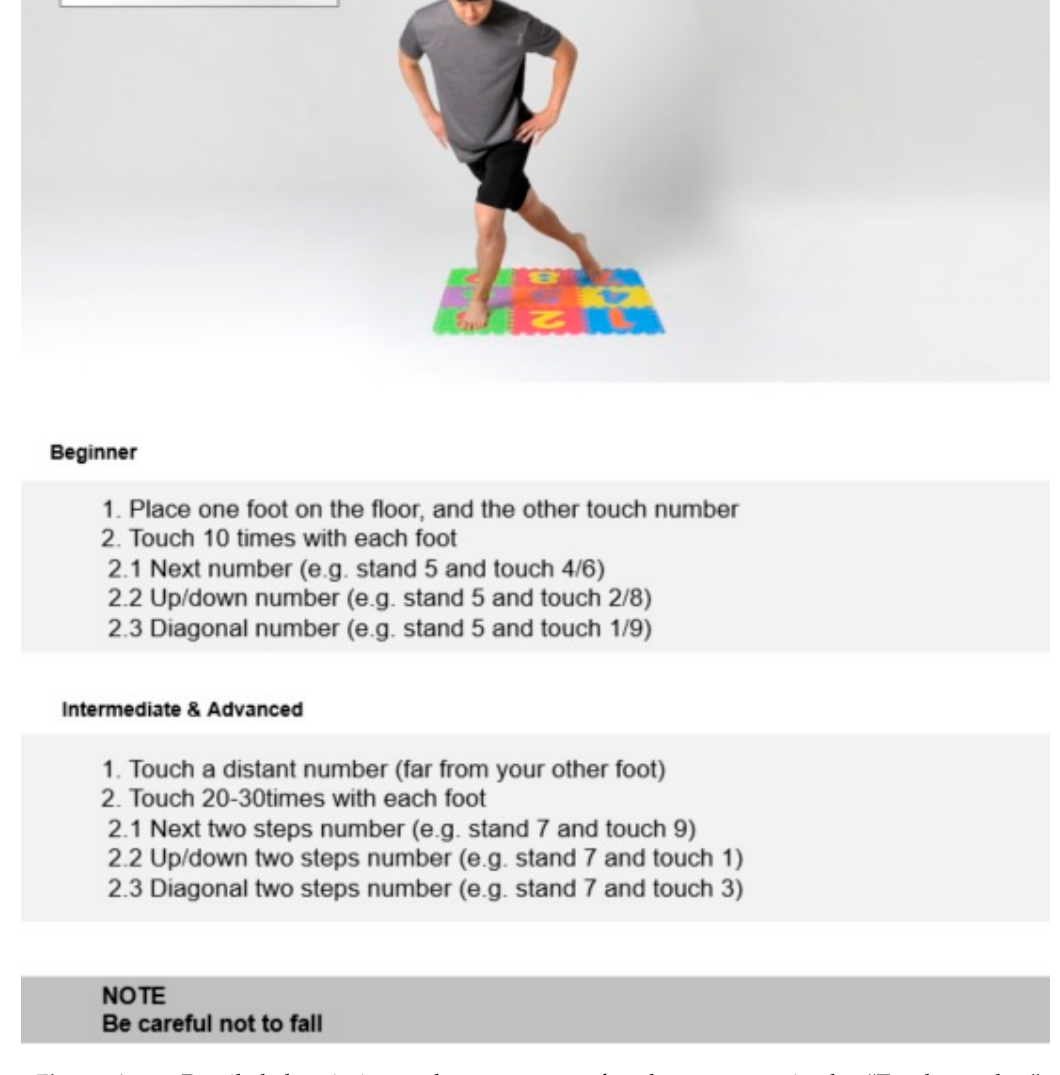
Figure A19. Detailed description and components of each movement in the “Touch number” balance exercise.